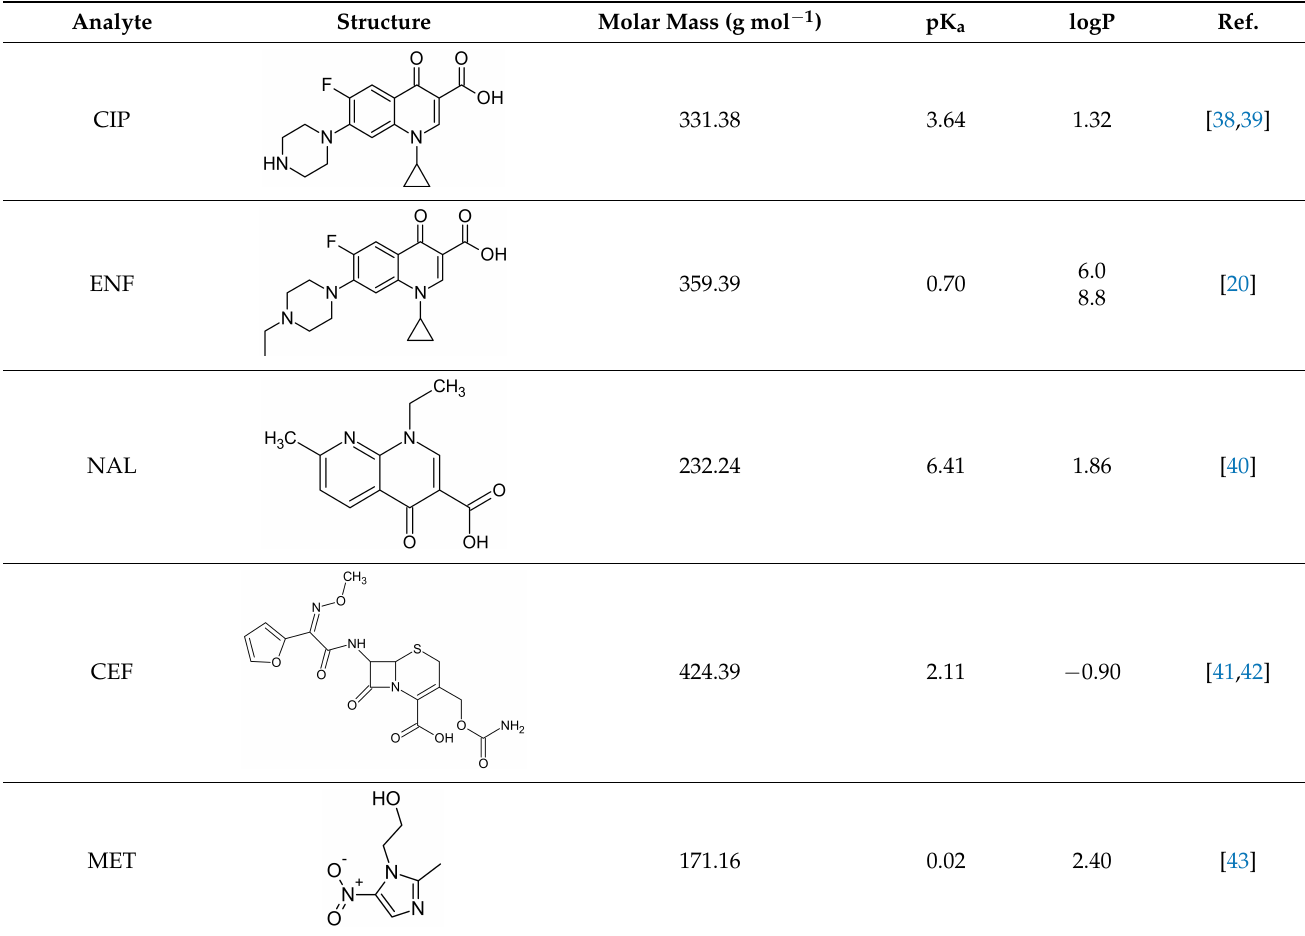
Table 1. Physicochemical properties of selected